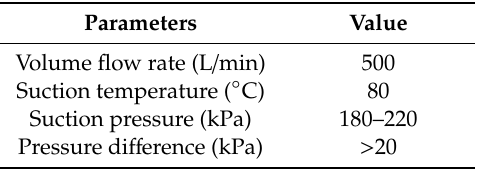
Table 1. Specification parameters of the Roots